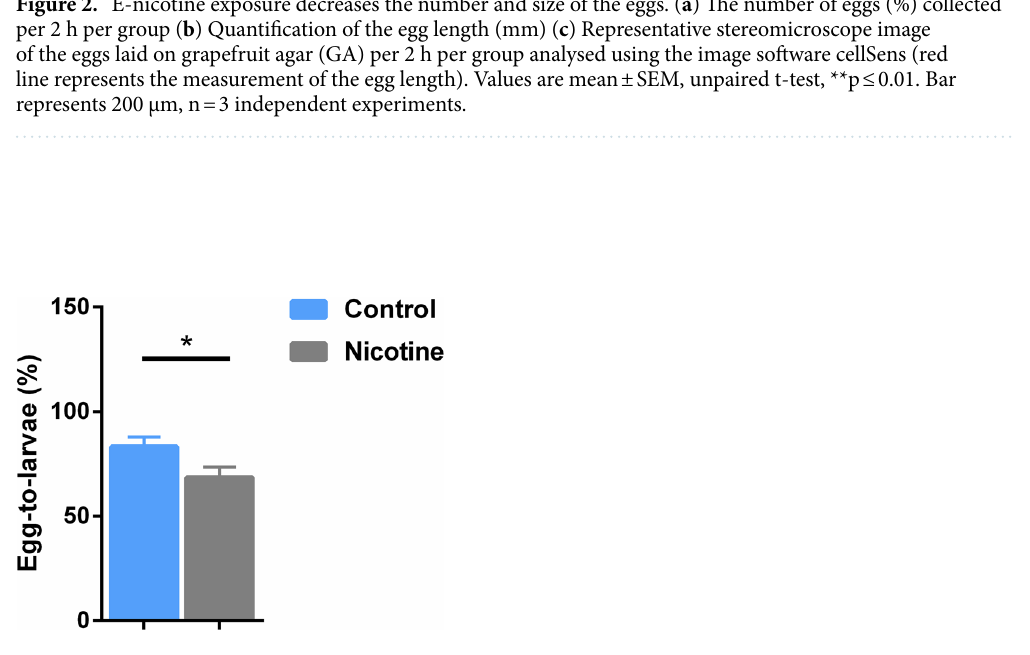
Figure 3. The rate of egg-to-larvae development. The percentage of egg-to-1st instar larvae development. Values are mean ± SEM, unpaired t-test, **p ≤ 0.05, n = 3 independent